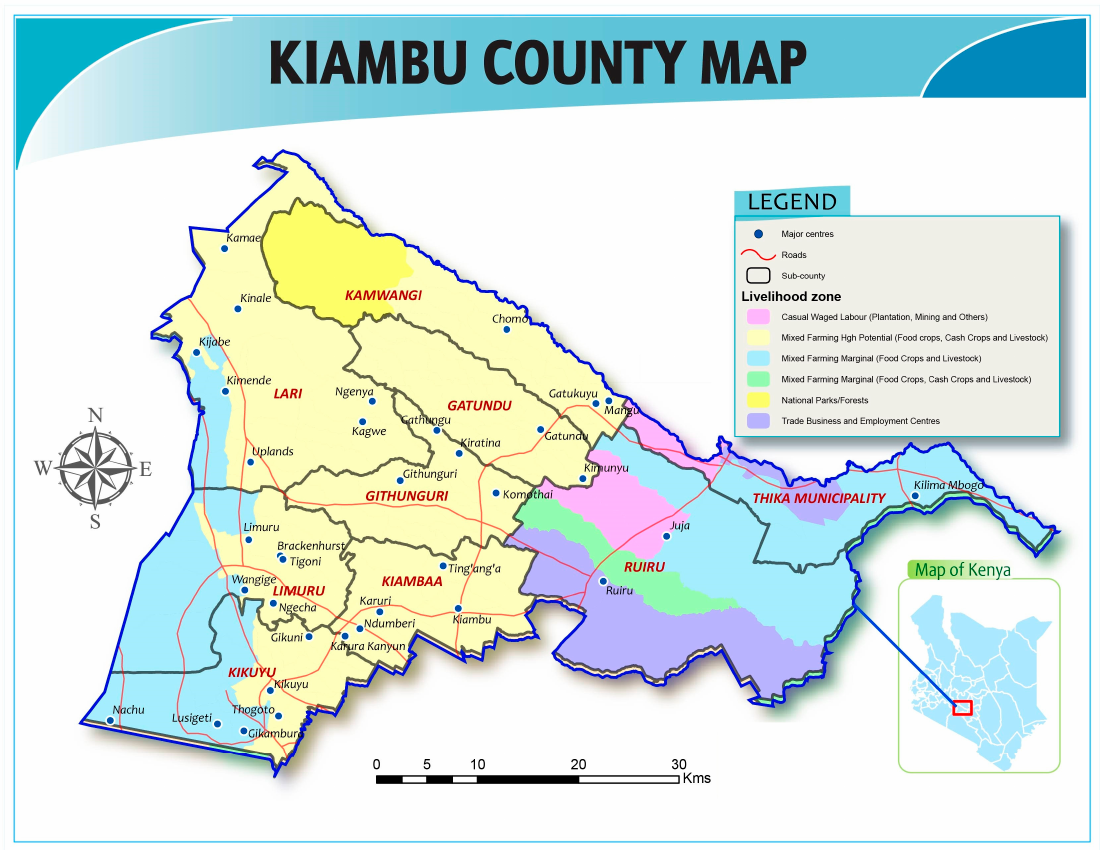
Figure 1. Map of study area. Compiled by FAO Kenya. Projection in Decimal Degrees with WGS 84